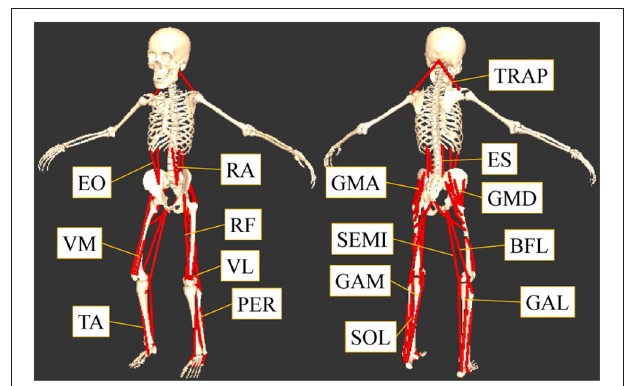
FIGURE 1 | The measured sixteen muscles. This study focused on the muscles that contribute to the flexion or extension of the lumber, hip, knee, and ankle joints: tibialis anterior (TA), gastrocnemius lateralis (GAL), gastrocnemius medialis (GAM), soleus (SOL), peroneus (PER), rectus femoris (RF), vastus lateralis (VL), vastus medialis (VM), biceps femoris long head (BFL), semitendinosus (SEMI), gluteus maximus (GMA), gluteus medius (GMD), rectus abdominis (RA), external oblique (EO), elector spine (ES), and trapezius